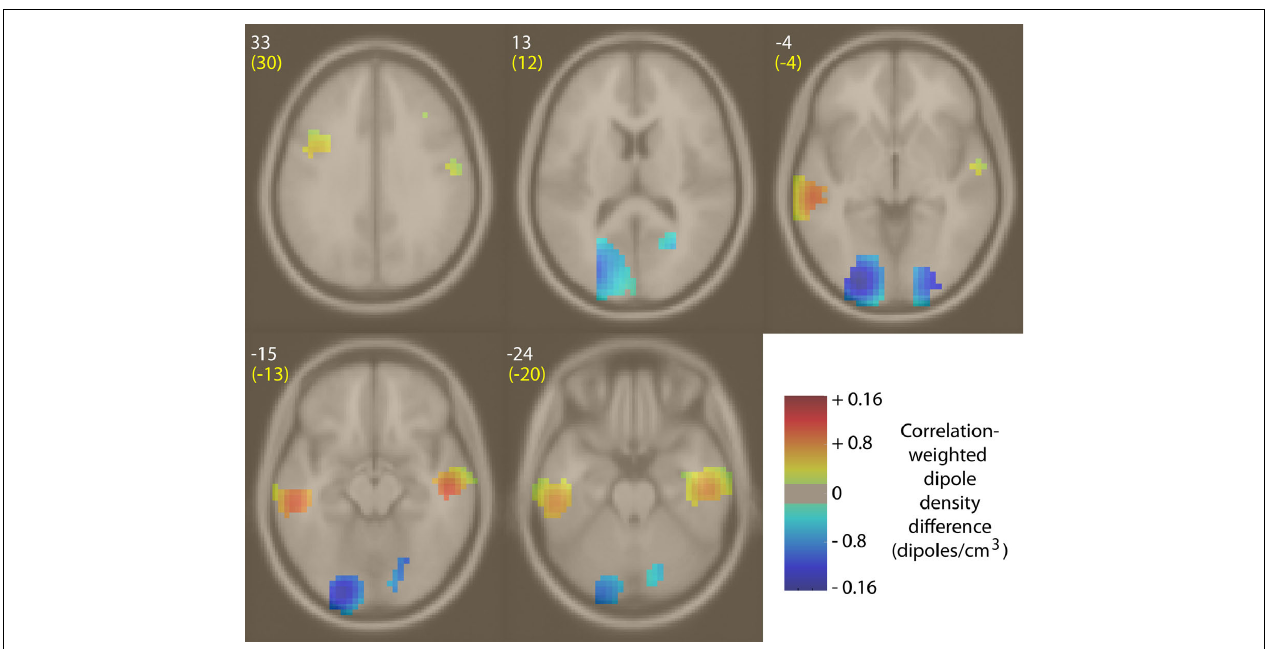
FIGURE 10 | Difference between positive and negative correlation- weighted IC equivalent-dipole densities of IMs whose median weights, across 14 emotion imagination periods, were positively or negatively correlated with behaviorally rated emotion valence. Regions of non-signifi cant density differences were masked using permutation statistics ( p > 0.003, uncorrected). Areas of signifi cant density difference between